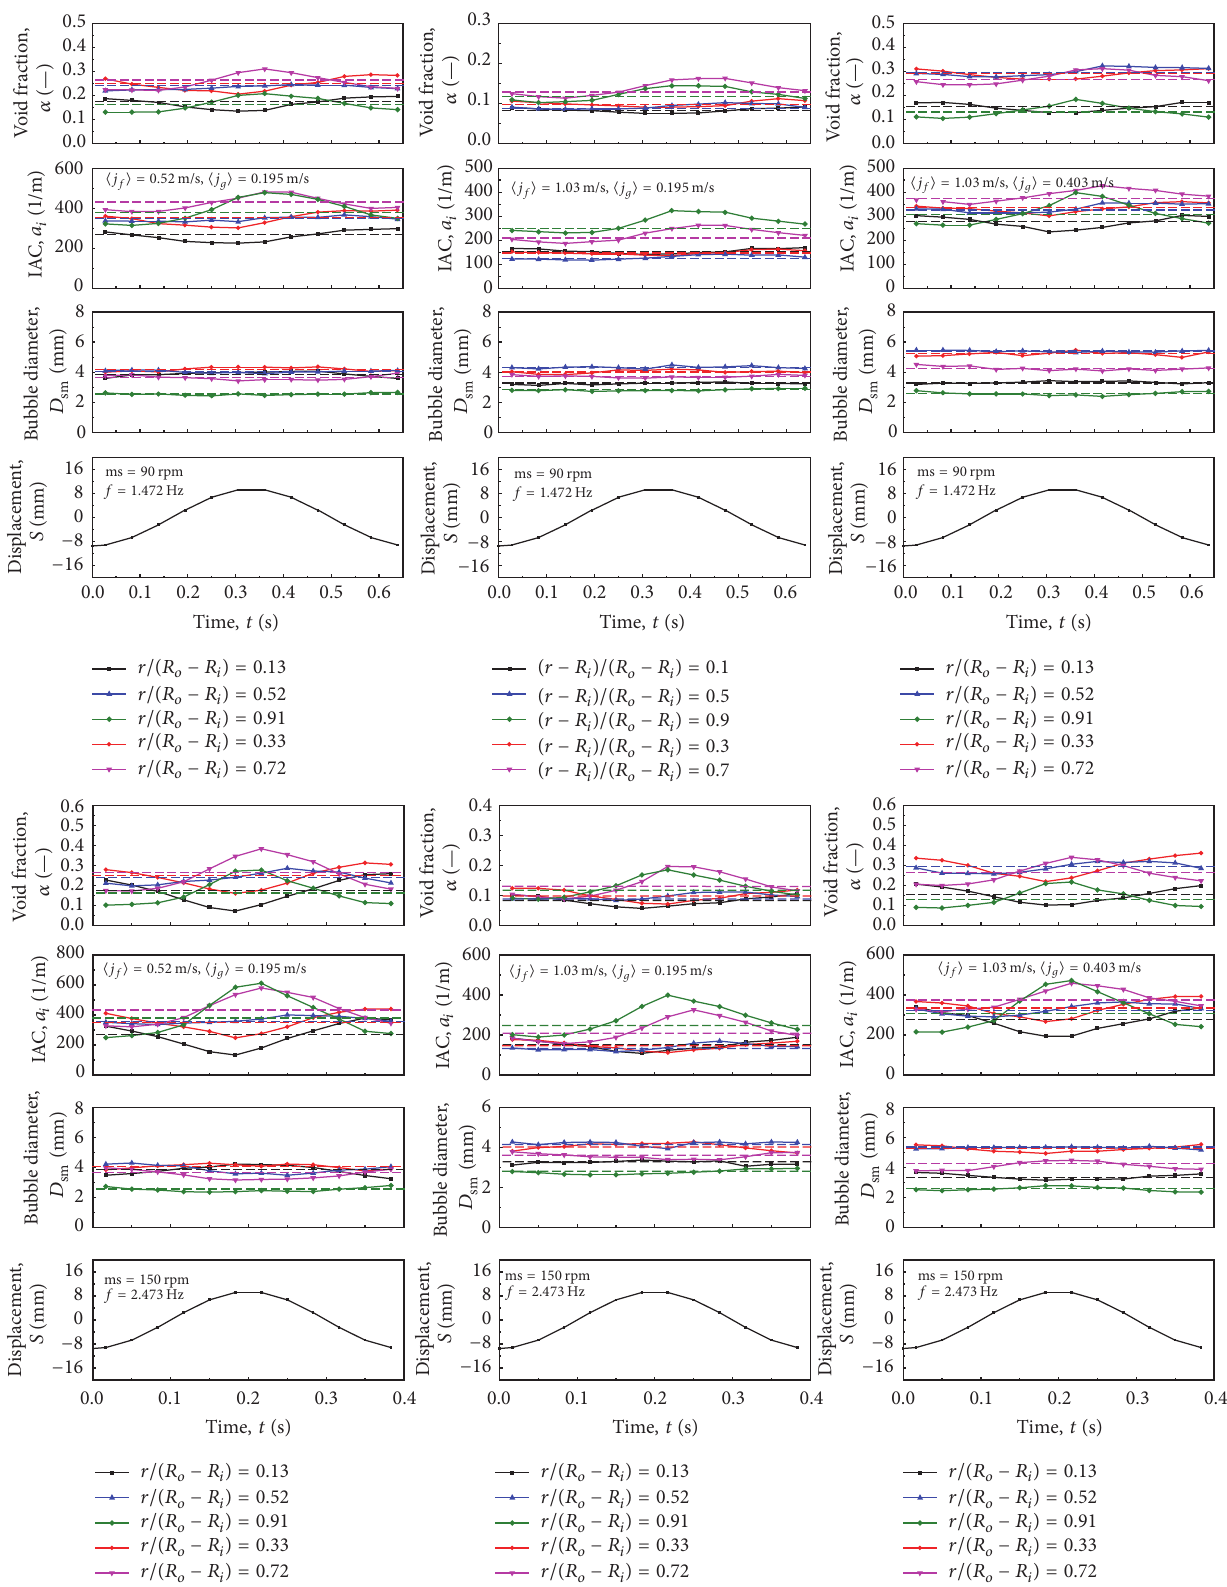
Figure 6: Variation of local flow parameters in the vibration